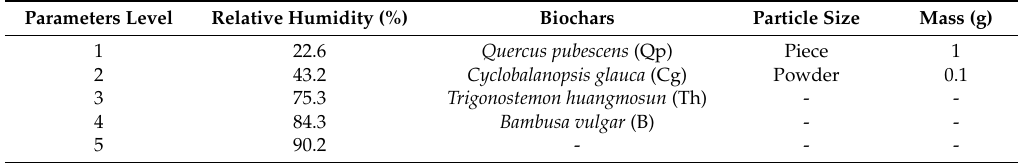
Table 2. Values of the parameters selected for the experimental design.